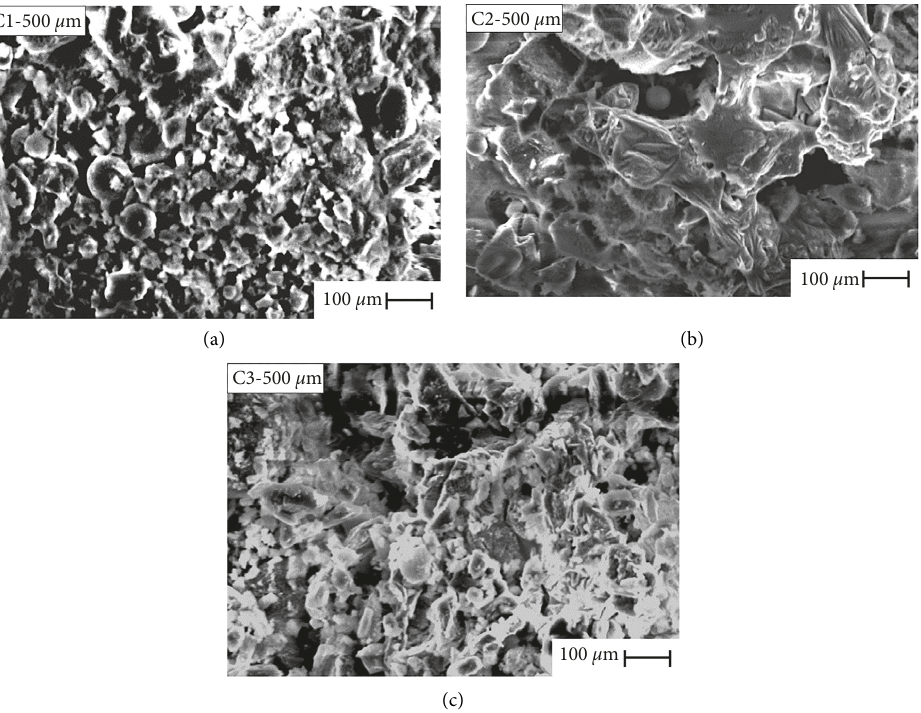
Figure 12: Surface microstructure of coati©(C). (a) C1. (b) C2. (c)